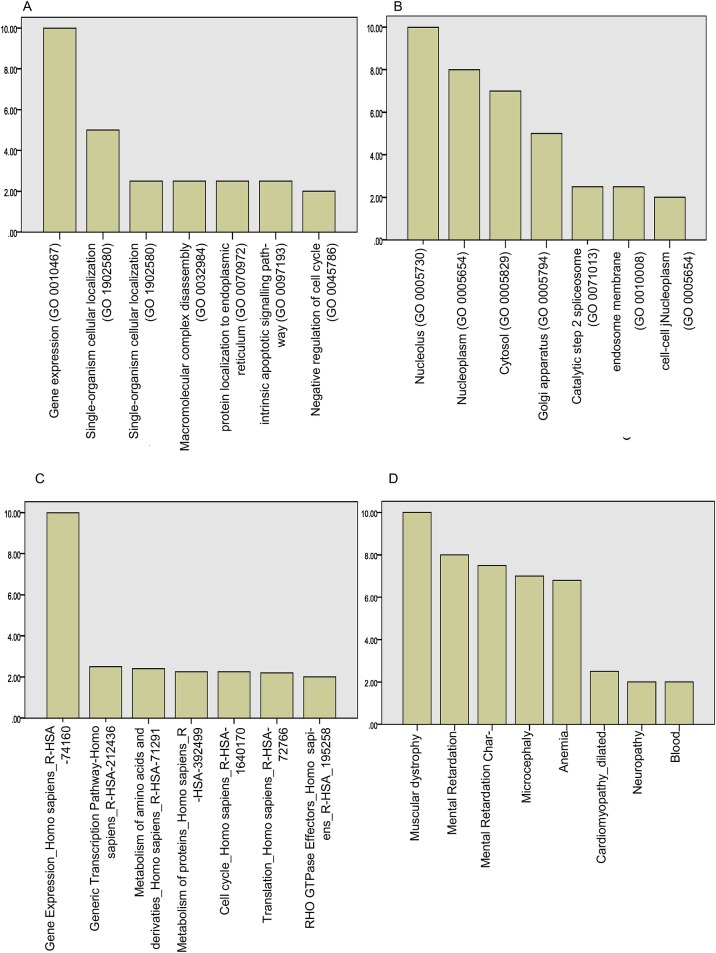
Gene expression profiling of MYT1L knockout cell line.(A)Enrichment analysis demonstrates enrichment for Gene Ontology Biological Process 2015 term gene expression (GO:0010467, adjusted p-value 0.00077, Z-score -2.34, combined score 16.77). (B)Enrichment analysis demonstrates enrichment for Gene Ontology Cellular Component 2015 terms nucleolus (GO: 0005730, adjusted p-value 0.0023, Z-score -2.21, combined score 13.43) and nucleoplasm (GO: 0005654, adjusted p-value 0.005853, Z-scre -2.08, combined score 11.4). (C)Enrichment analysis demonstrates enrichment for Reactome 2016 pathways Gene Expression_Homo Sapiens_R-HAS-74160 (adjusted p-value 2.2 x 10–7, Z-score -2.16, combined score 33) and Generic Transcription Pathway_Homo Sapiens_R-HAS-212436 (adjusted p-value 0.01586, Z-score -2.26, combined score 9.35). (D)Enrichment analysis demonstrates enrichment for OMIM disease term mental retardation (p-value 0.045, adjusted p-value 0.38, Z-score -1.32, combined score 1.27).